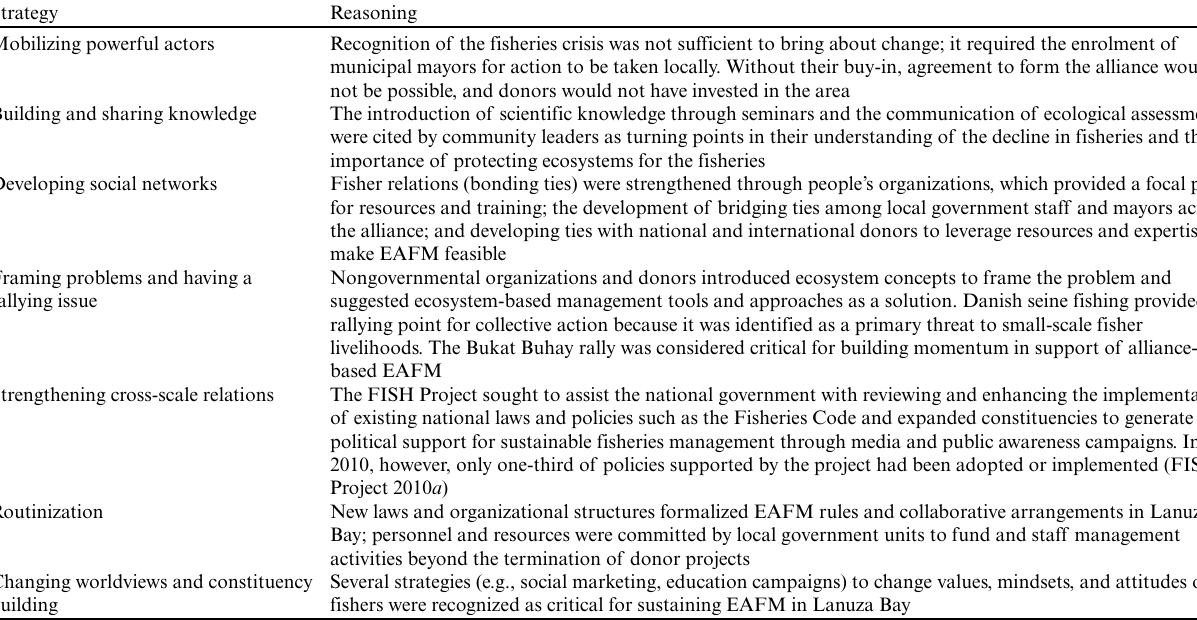
Table 3. Strategies for enabling and institutionalizing an ecosystem approach to fisheries management (EAFM) in Lanuza Bay,